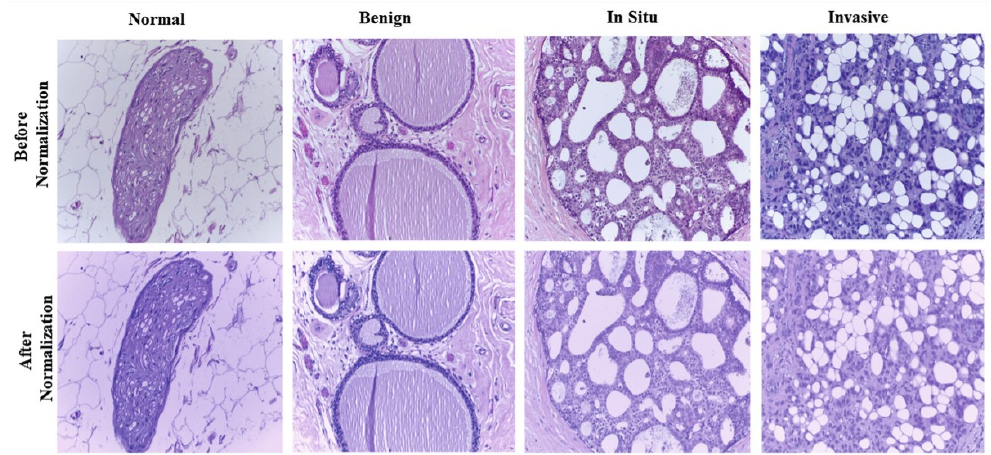
Figure 8. Histology images before and after stain normalization condition. Reproduced with per- mission from [158].